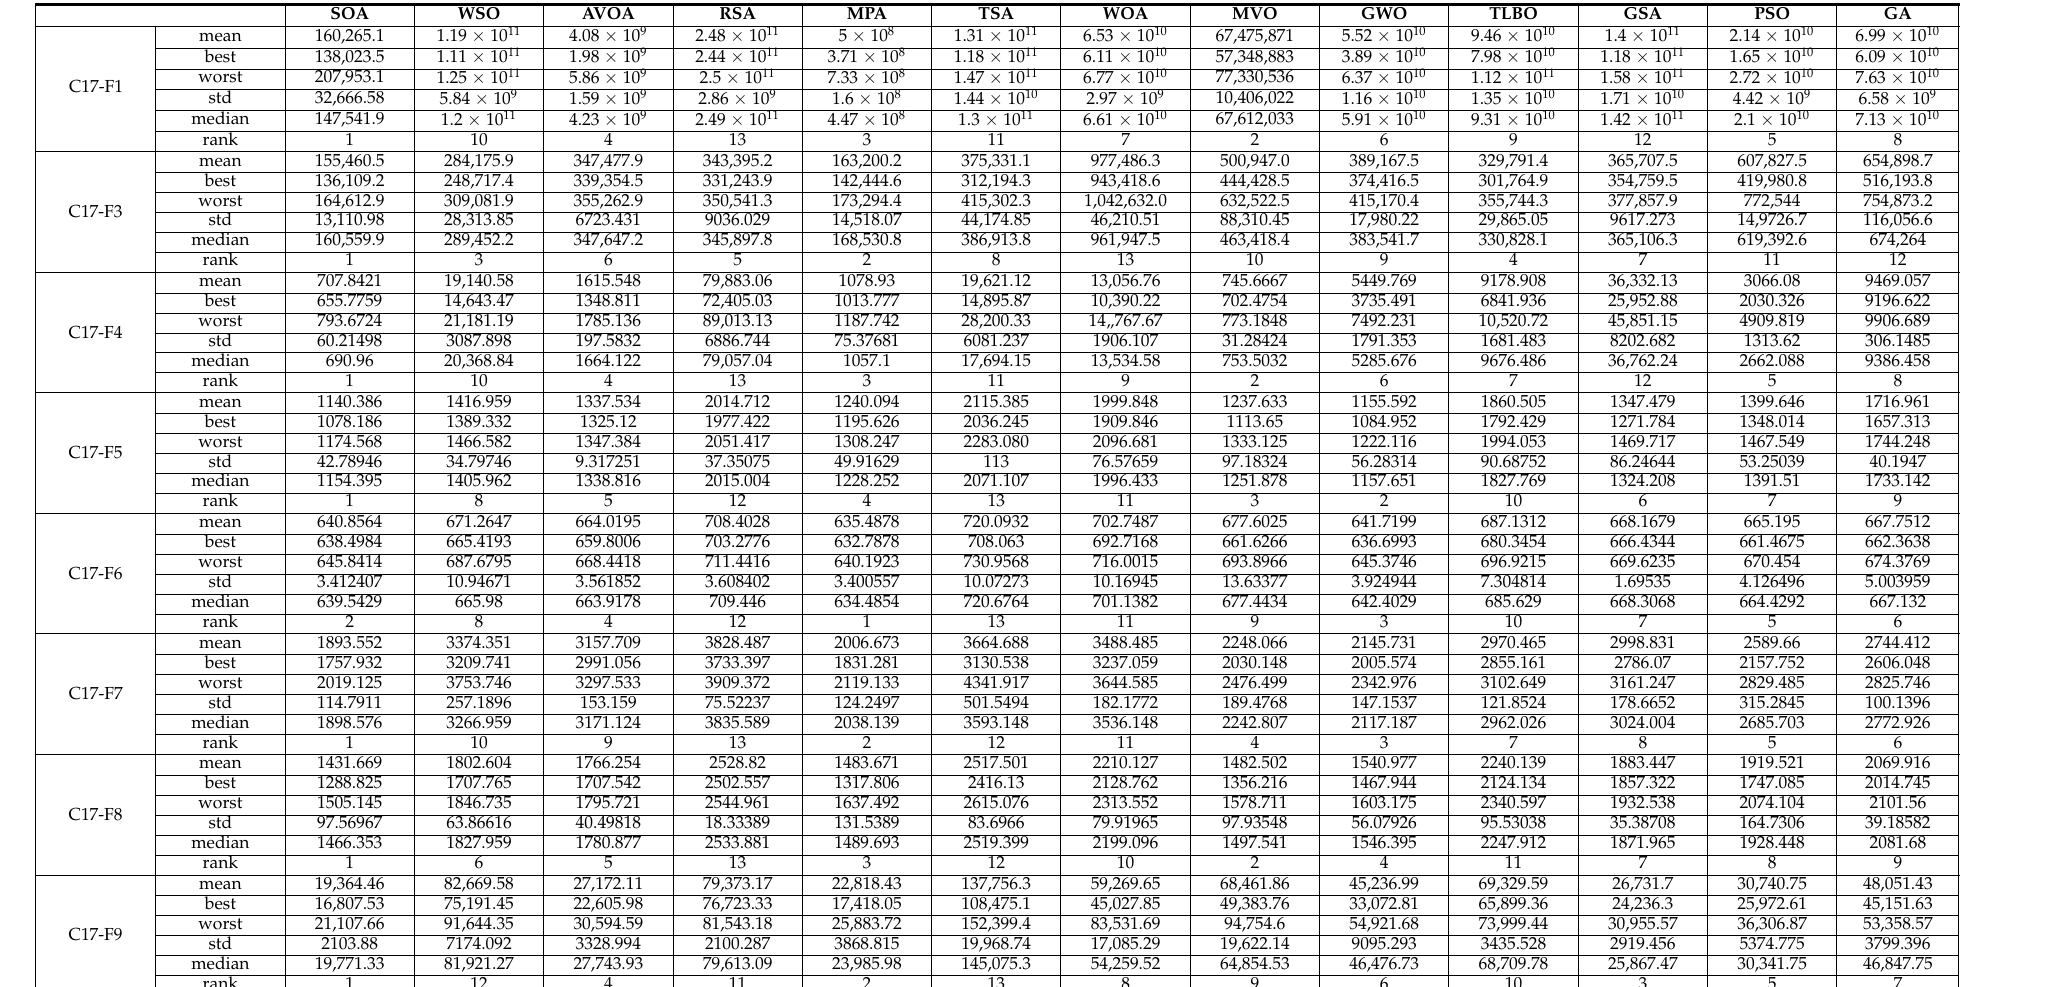
Table 5. Optimization results of the CEC 2017 test suite (for the dimension d =